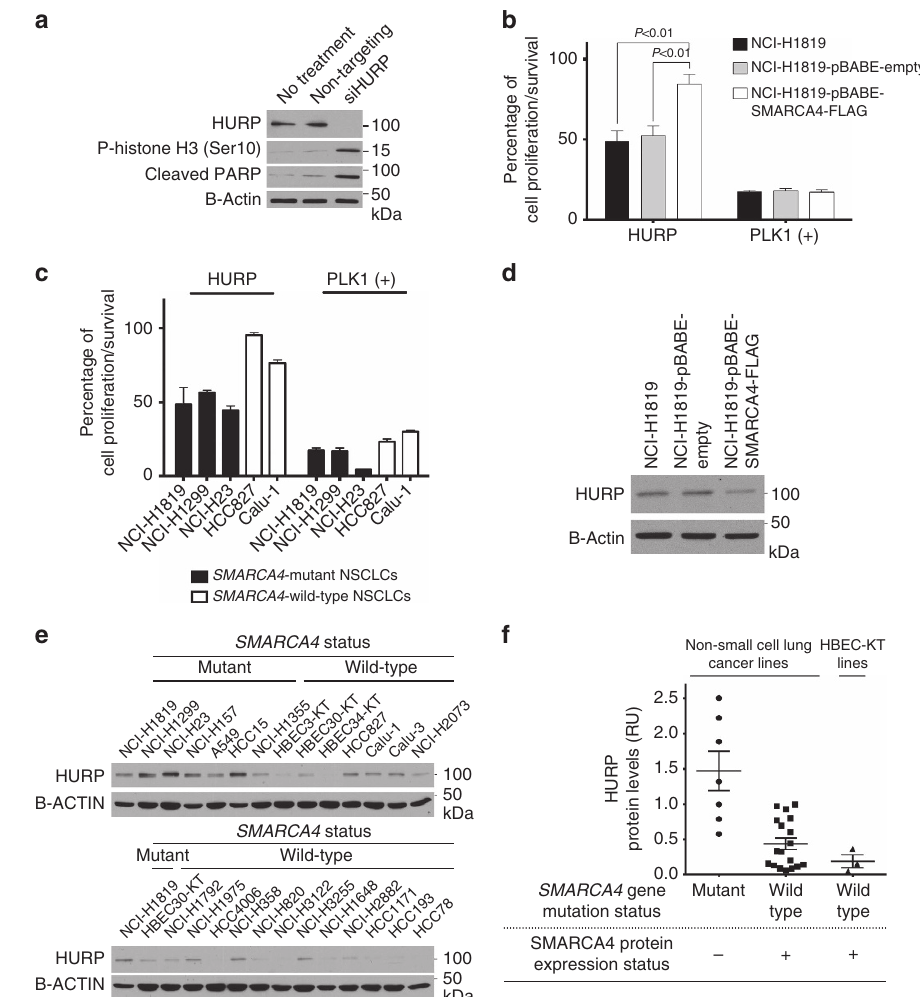
Figure 5 | Restoring wild-type SMARCA4 in NCI-H1819 cells reduces the cytotoxicity induced by the depletion of HURP. ( a ) The response to depleting HURP with a pool of four individual siRNAs was measured with monoclonal antibodies to HURP, cleaved PARP (indicating apoptosis) and phospho-Histone H3 (indicating cells engaged in mitosis). ( b ) Five days after depleting HURP in NCI-H1819, NCI-H1819-pBABE and NCI-H1819-pBABE-SMARCA4-FLAG cells and ( c ) in NCI-H1819, NCI-1299, NCI-H23, HCC827 and Calu-1 cells, cell viability was measured with a CellTiter-Glo assay as in Figs 2 and 3. PLK1 was depleted as the positive control. Data are means with s.d. of triplicate biological replicates and representative of triplicate experiments. ( d ) Cell lysates of NCI-H1819, NCI-H1819-pBABE and NCI-H1819-pBABE-SMARCA4-FLAG cells were immunoblotted with monoclonal antibodies to HURP. ( e ) HURP expression was measured in a panel of SMARCA4 -mutant or wild-type NSCLCs and HBECs by immunoblotting. ( f ) HURP protein band intensities were measured with the ImageQuant software and graphed. Horizontal bars indicate means and s.e.m. of sample groups. Statistical significance on graphs was assessed by one-way ANOVA and post hoc Dunnet’s multiple comparison